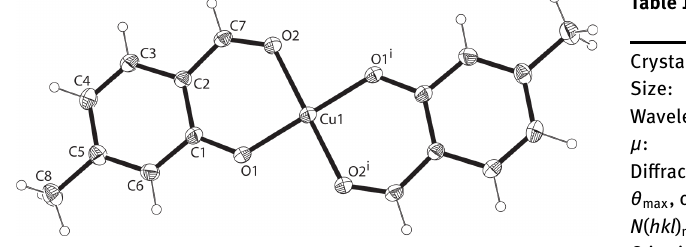
Table 1: Data collection and handling.